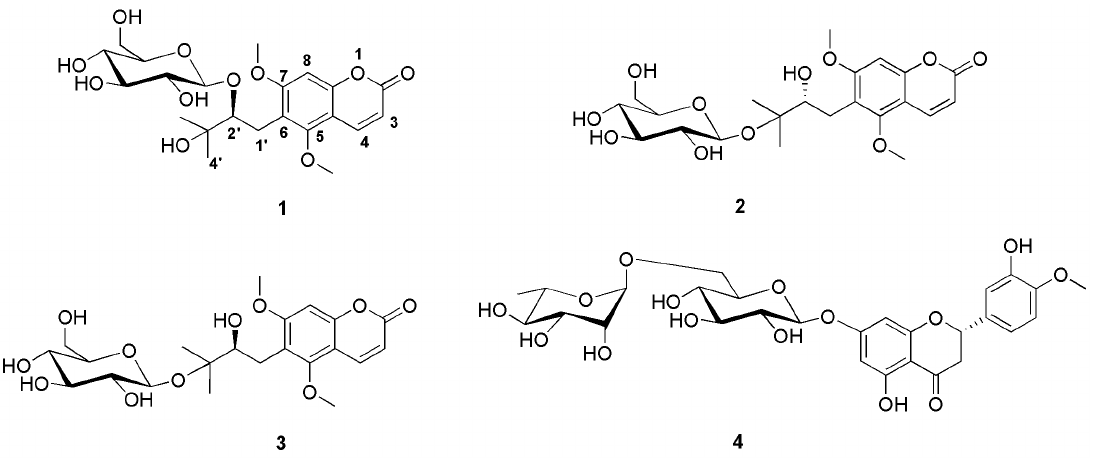
Figure 5. Chemical structures of the separated compounds 1 – 4 .